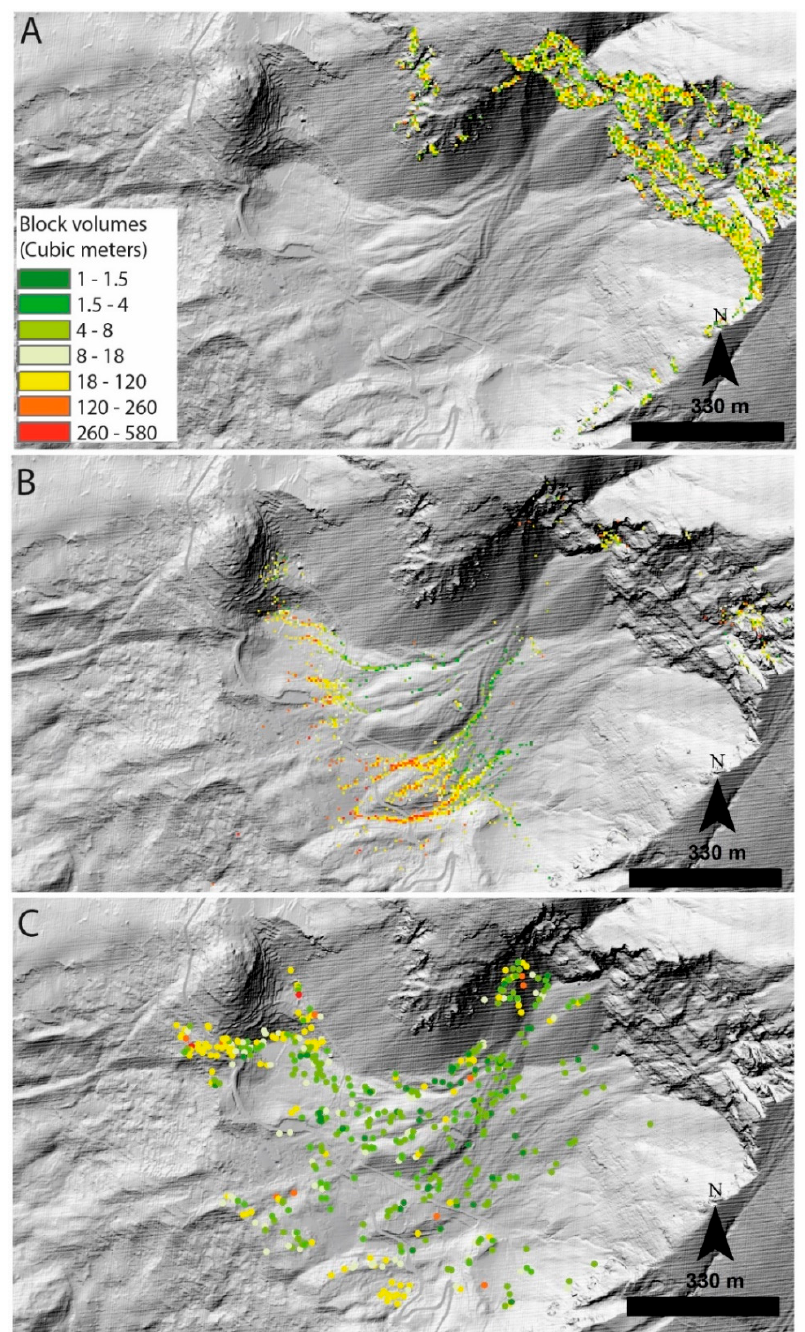
Figure 18. ( A ) Example of block volume distribution within release cells using the proposed procedure. ( B ) Results of the rockfall simulations using relative rockfall block volume frequency. ( C ) Map of recent rockfall events. Color scheme reported in (A) is the same used for (B) and (C).